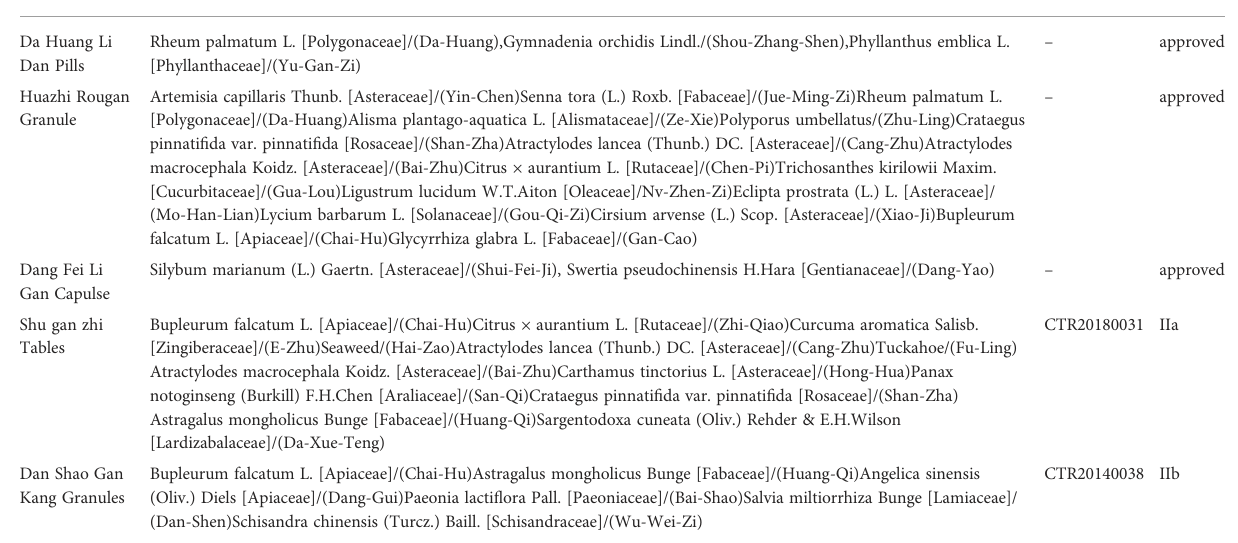
TABLE 1 Chinese patent medicine treating NAFLD target to DHS.